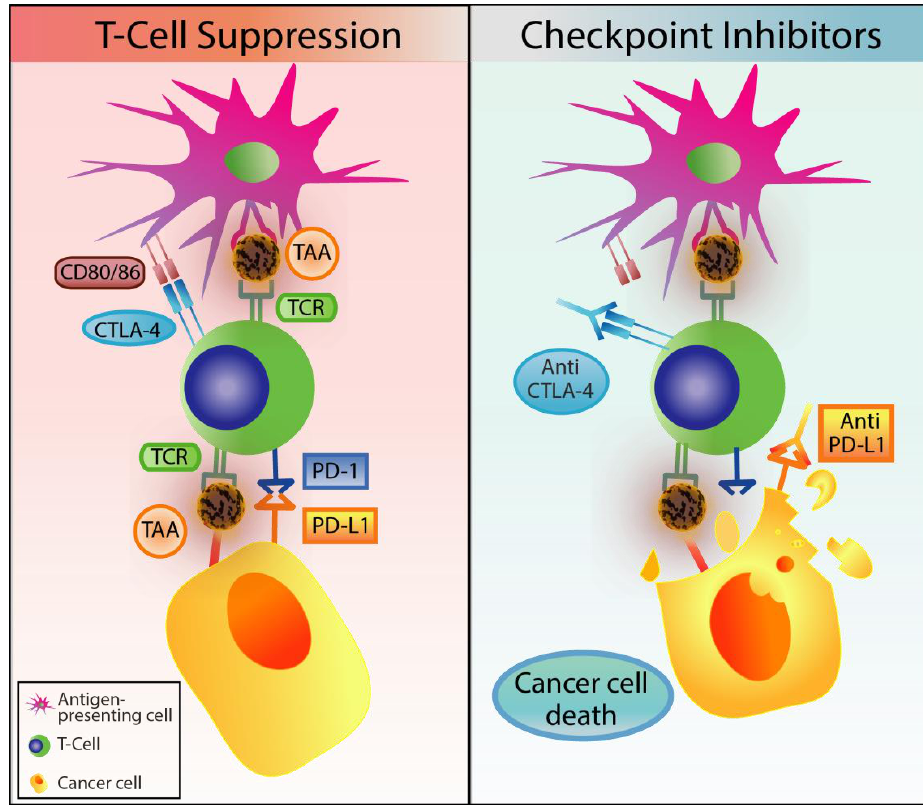
Figure 2. Immune checkpoint blockade of T-cell activity and mechanism of action of checkpoint inhibitors. The immune checkpoints regulate T-cell activity and are crucial for maintaining self-tolerance. However, in cancer, the endogenous T-cell immune checkpoints, CTLA-4 and PD-1, inhibit T-cell activity when bound to their ligands, CD80/86 (antigen-presenting cells) and PD-L1 (cancer cells), respectively. Treatments with checkpoint inhibitors can disrupt this regulatory interaction allowing T-cell cytotoxic activity against cancer cells.